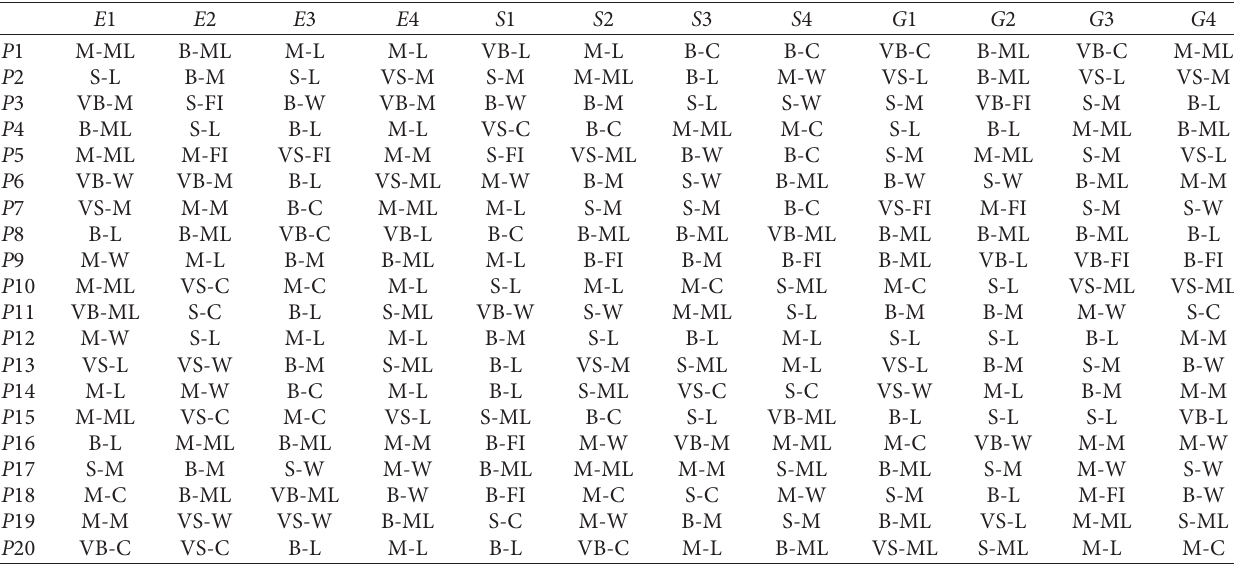
Table 46: Probabilistic linguistic scoring matrix of sustainability criteria for proposed projects.